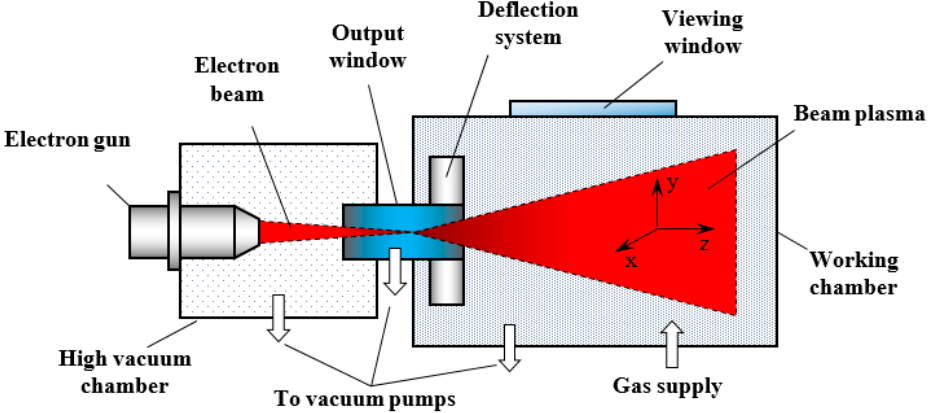
Figure 6. Schematic diagram of a beam-plasma reactor for the synthesis of dielectric coatings [70]. An electron beam is focused in the gas-dynamic output window with a diameter of 2 mm, through which it is injected into the reactor working chamber with a volume of 150 L. The components of the plasma-forming medium, Si (C 2 H 5 O) 4 + O 2 , are fed into the